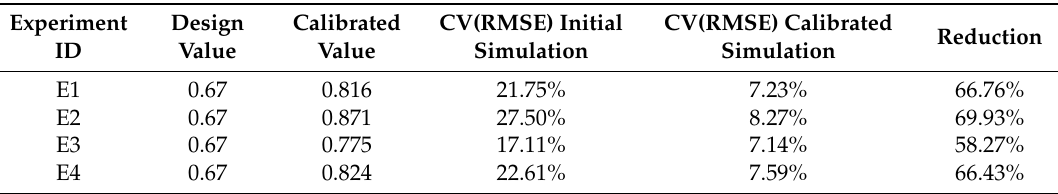
Table 2. Value of the Maintenance Factor and the CV(RMSE) for the different experiment cases, before and after calibration.